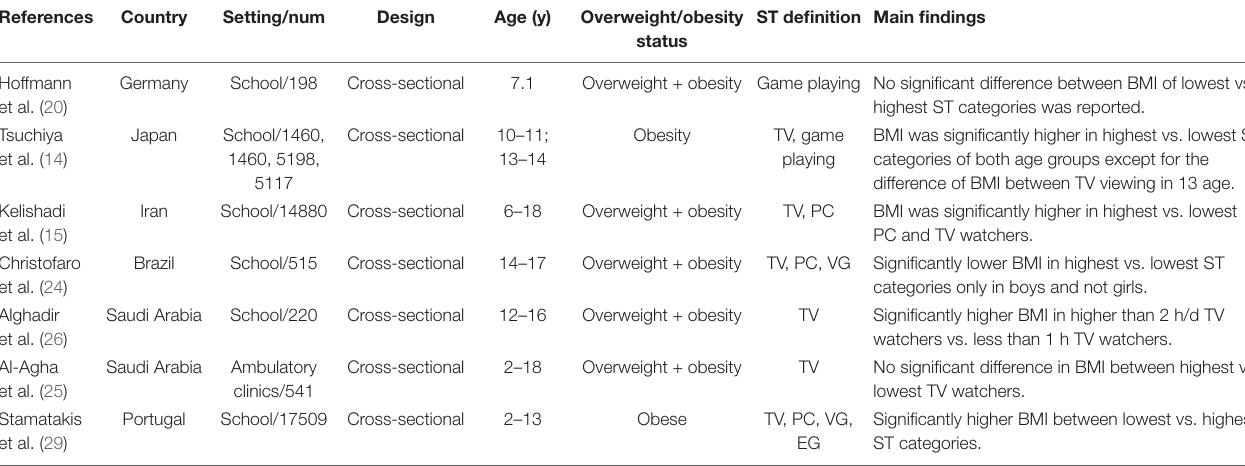
TABLE 1 | The evidence of studies that were included in the two-class meta-analysis of comparison of BMI between highest vs. lowest ST categories.